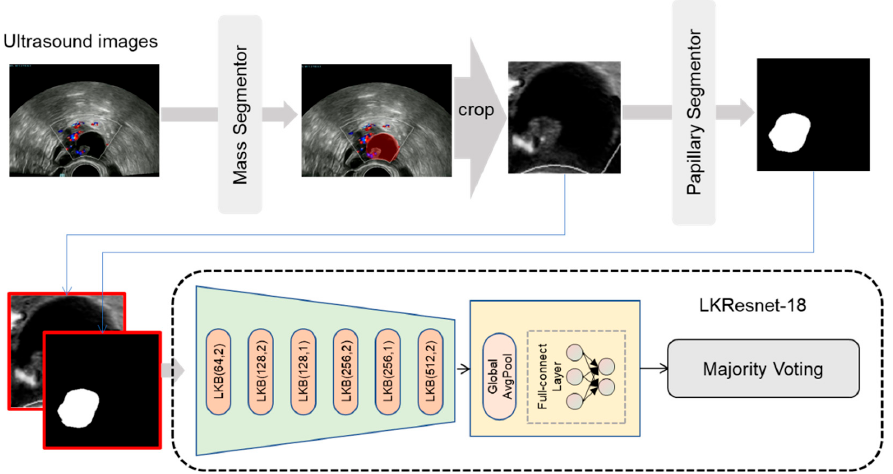
Figure 2. The framework of the type and pathological subtype classifiers. “LKB (c,s)” refers to a basic large kernel block containing two depthwise–pointwise convolutions with output channels of c and strides of s. For each image, including color doppler flow images and two-dimensional sonographic images, the mass segmentor was used to locate the tumor region. Then the image was cropped to just the tumor region. The papillary segmentor was used to locate the papillary region in the tumor area. The papillary region and tumor region were concatenated as the input into the